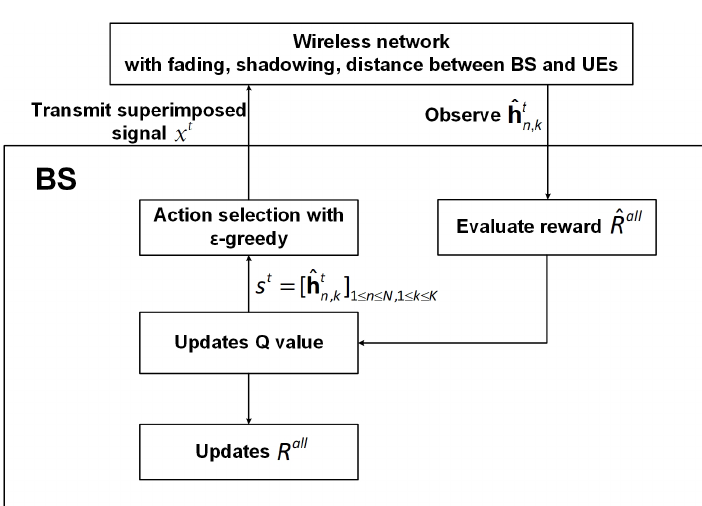
Figure 5. Illustration of the Q-learning-based joint user pairing and power allocation